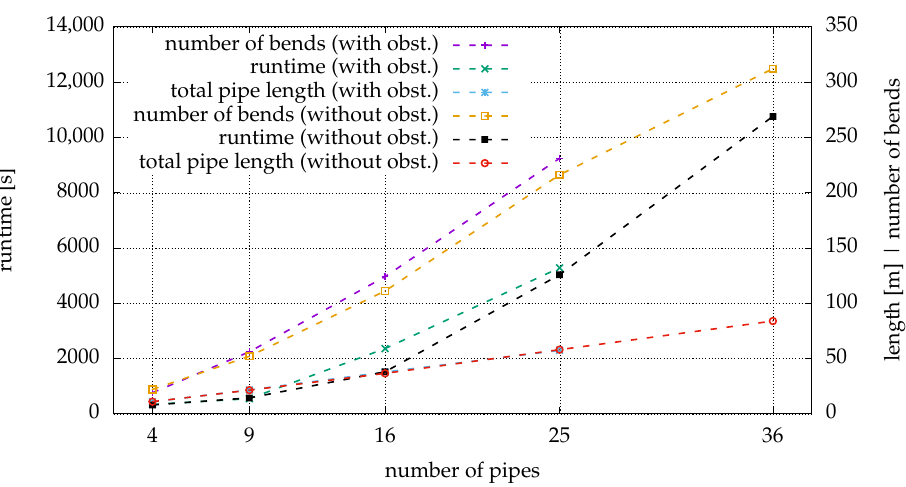
Figure 18. Comparison of the piping results without and with obstacle.